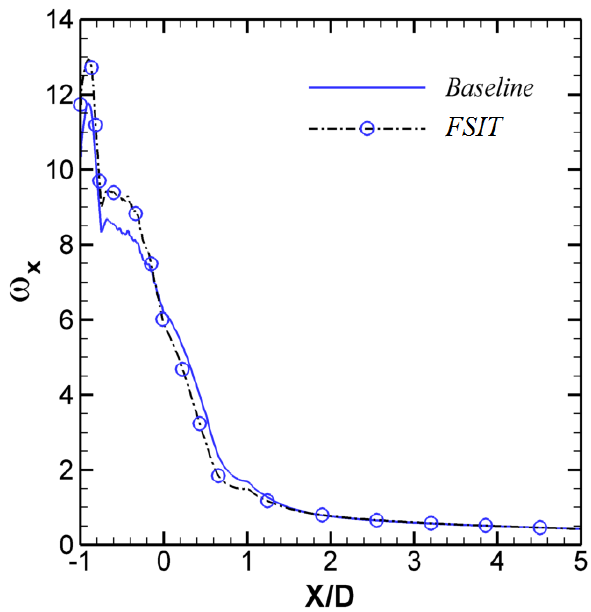
Figure 10. Impact of the in-pipe boundary layer on the CRVP development.